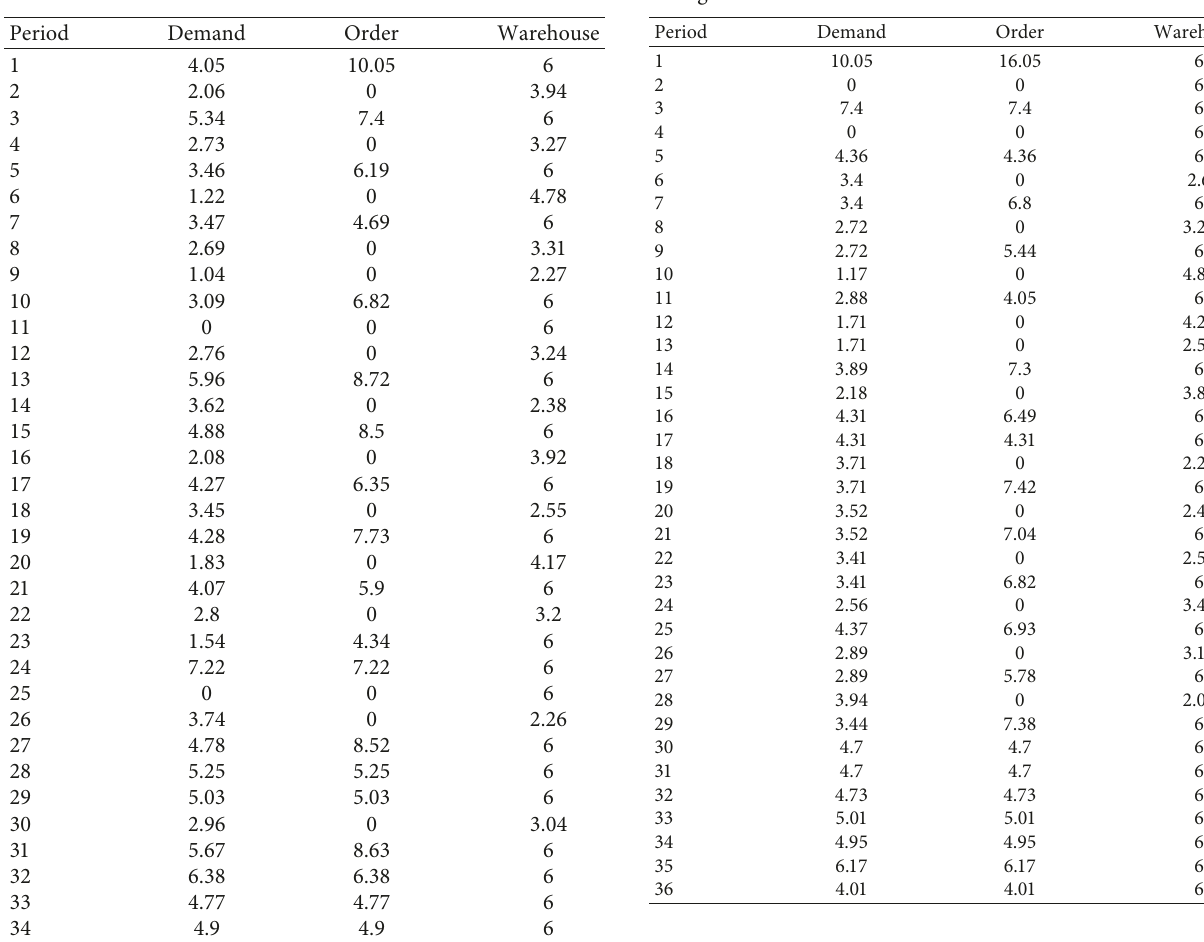
Table 7: Demand and order and supplier warehouse by the moving average method.